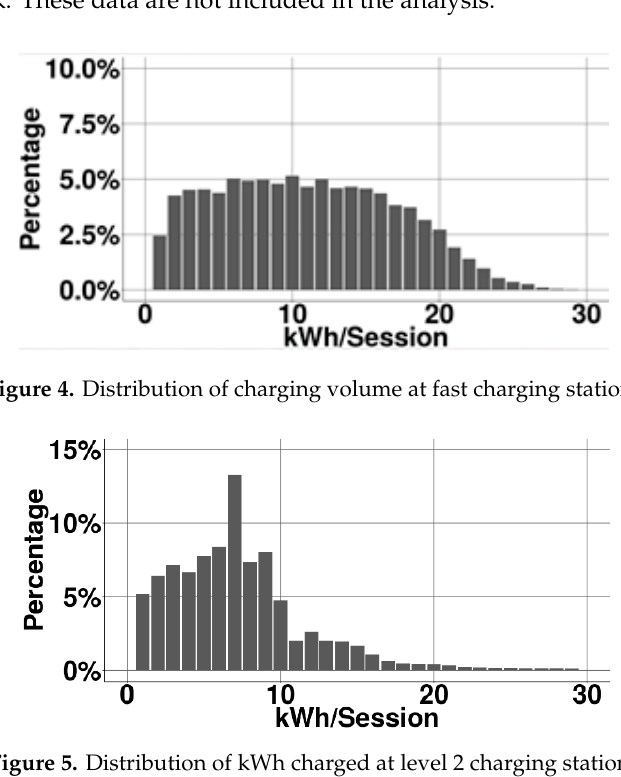
Figure 4. Distribution of charging volume at fast charging stations.